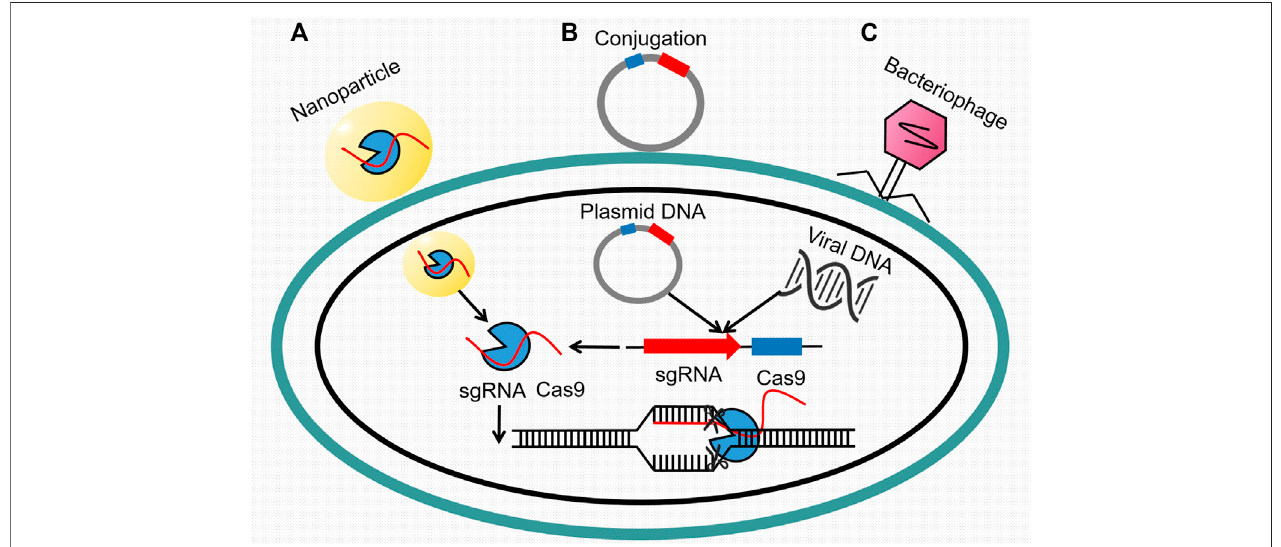
FIGURE 4 | Transport of the CRISPR Cas9 system through three approaches. (A) Nanoparticles carrying single-guide RNA and Cas9 protein, (B) plasmid DNA throughconjugation,and (C) viralDNAthroughbacteriophageinvasionmakeupthemainsourcesoftheacquiredCas9systemintargetbacterialcell.Thereafter,sgRNA recognizes the speci fi c resistance gene segments in chromosomal DNA, and Cas9 protein conducts cutting activity.